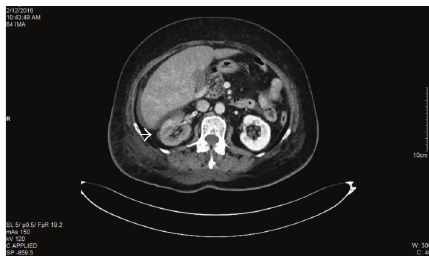
Figure2:Contrast-enhancedCTscan.Decreaseduptakeofcontrast in the right kidney. The white arrow shows the right kidney with small areas of contrast uptake suggestive of a partial occlusion of the right renal artery.